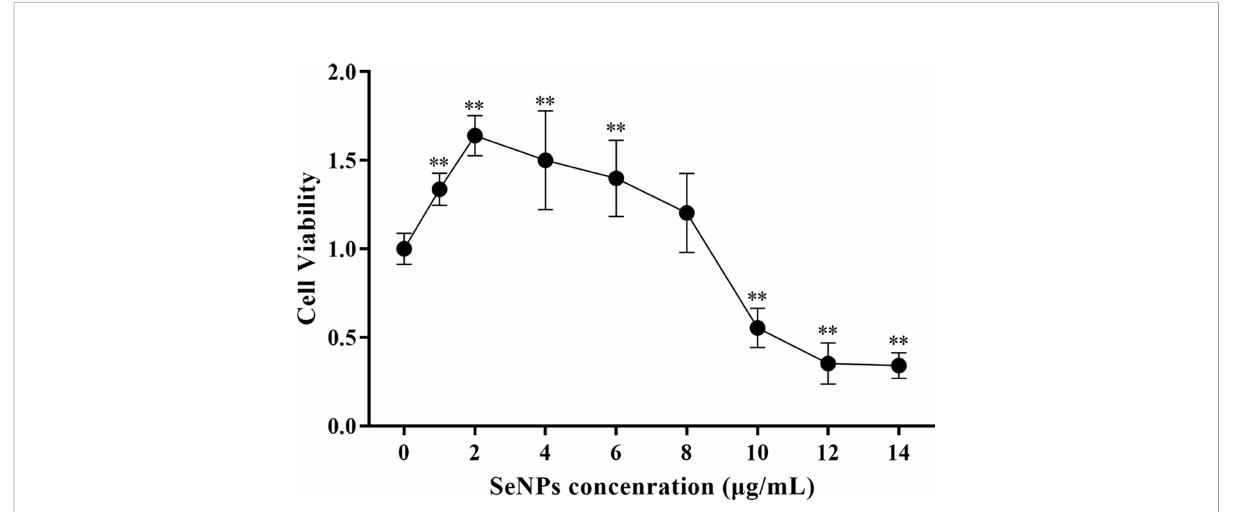
FIGURE 6 Effects of different SeNPs concentrations on the viability of ST cells In the fi gure ** indicates that the difference is extremely signi fi cant compared with the group added with 0 m g/mL SeNPs (P < 0.01), and no indication indicates that the difference is not signi fi cant ( P > 0.05), n=6.